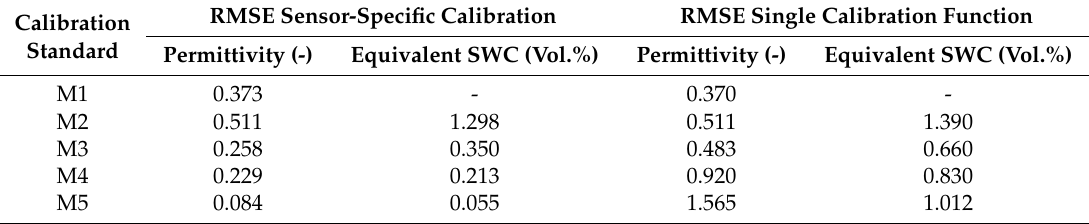
Table 4. RMSE between measured and reference permittivity using sensor-specific calibration and a single universal calibration, respectively, as well as the corresponding equivalent SWC calculated with the Topp equation